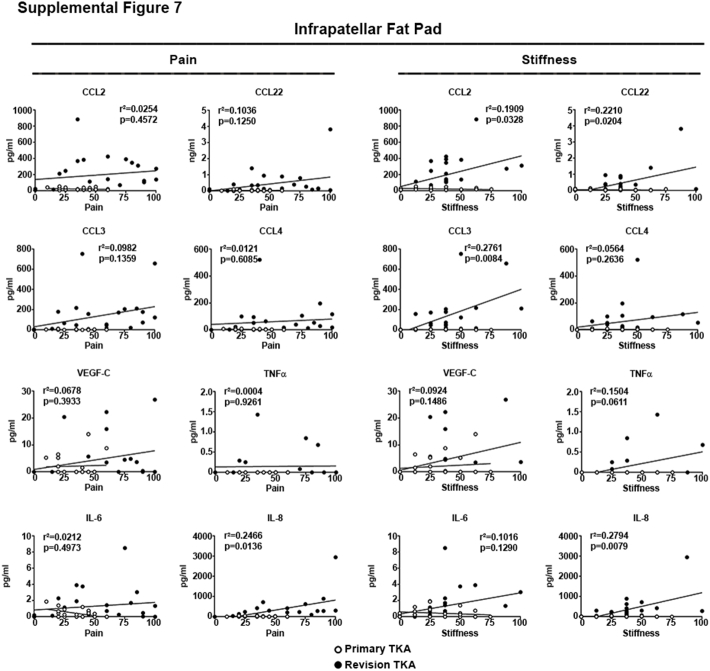
Pain and stiffness are poorly correlated to inflammatory markers in infrapatellar fat pad. Pain and stiffness, as determined by Western Ontario and McMaster Universities Osteoarthritis Index scores, were plotted against expression levels of several markers that were significantly elevated in patients undergoing revision total knee arthroplasty (TKA). Data are presented for patients undergoing primary and revision TKA, and correlations were determined by linear regression analysis. n = 20 primary TKA group; n = 24 revision TKA group. TNF, tumor necrosis factor; VEGF, vascular endothelial growth factor.